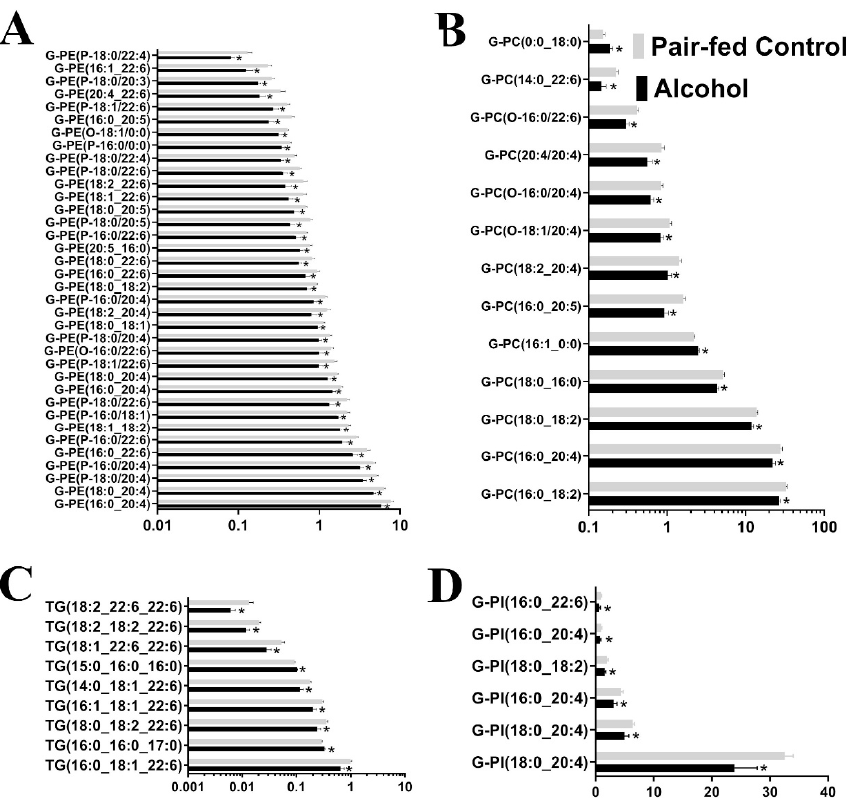
Figure 1. Signi fi cantly altered ( p < 0.05) glycerophospholipids in the maternal blood following ges- tational alcohol exposure. A total of 73 lipids were a ff ected by alcohol treatment. The four most a ff ected lipid species were Glycerophosphoethanolamines (G-PE; A ), Glycerophosphocholines (G- PC; B ), Triacylglycerols (TG; C ), and Glycerophosphoinositols (G-PI; D ). *, p < 0.05. Table 2. Class of lipids and their corresponding lipid subclass number, which was signi fi cantly al- tered following alcohol exposure in an untargeted lipidomic